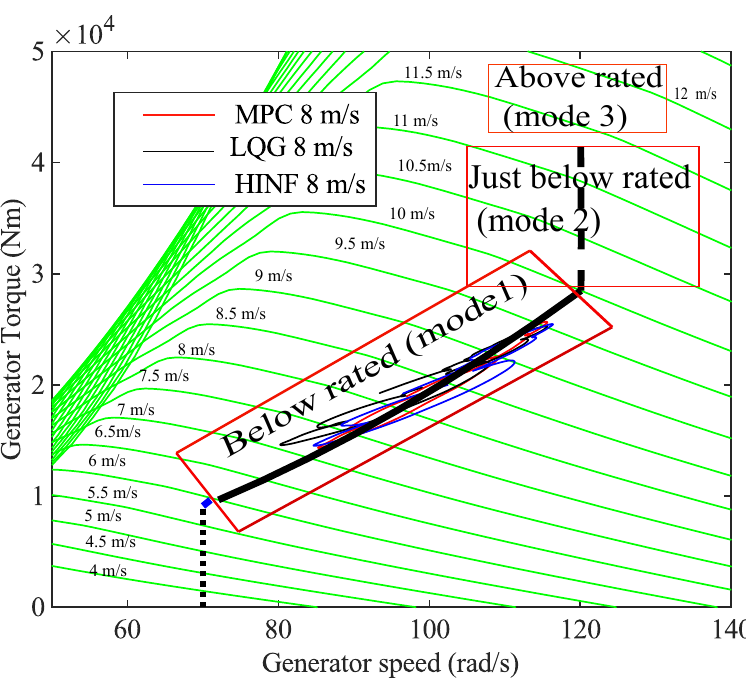
Figure 10. Behaviour of MPC, LQG, and H ∞ controllers in mode 1 on torque/speed